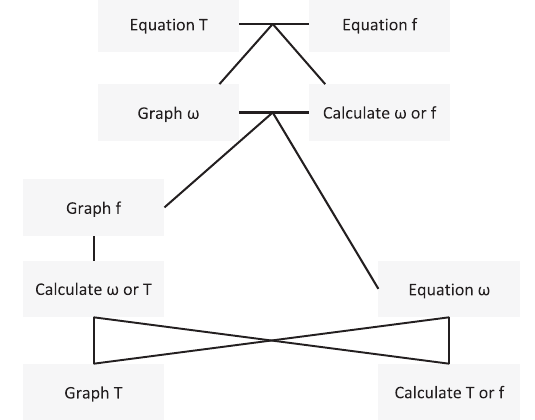
FIG. 4. Hierarchy of period, frequency, and angular frequency skills for the algebra-based students obtained using item tree analysis and the DAKS package for